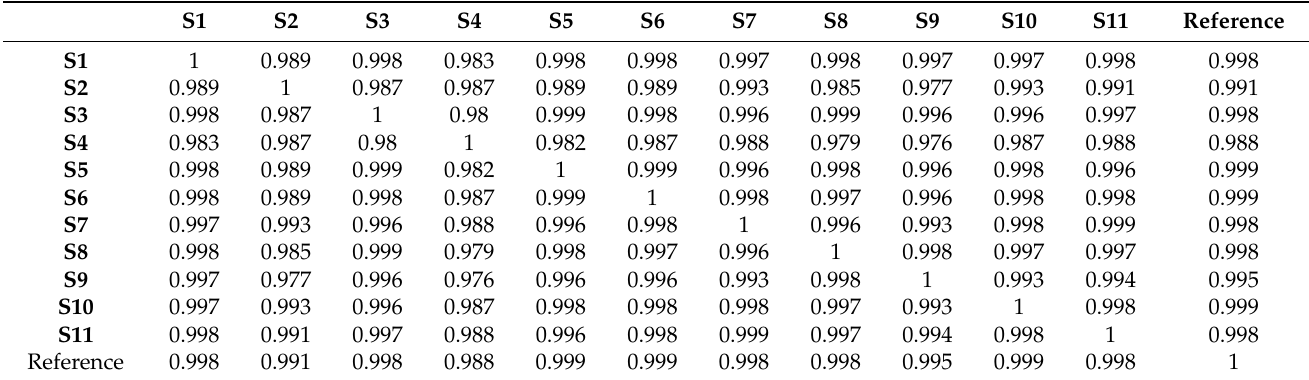
Table 4. The similarity of the eleven batches of TDL samples.